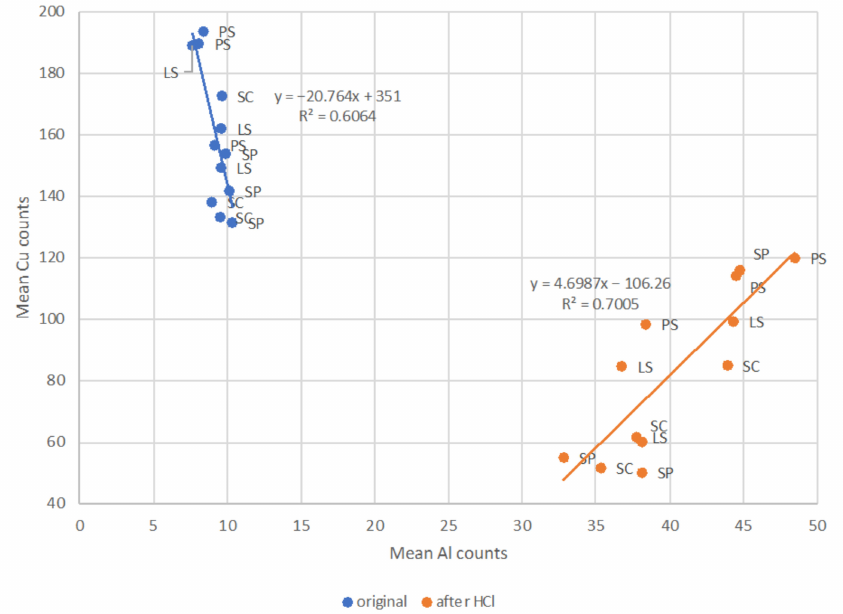
Figure 3. Relation of Al and Cu counts in untreated samples ( • ) and after HCl extraction ( • ). SP = Siberian spruce, LS = Siberian larch, PS = Siberian pine, SC = Scots